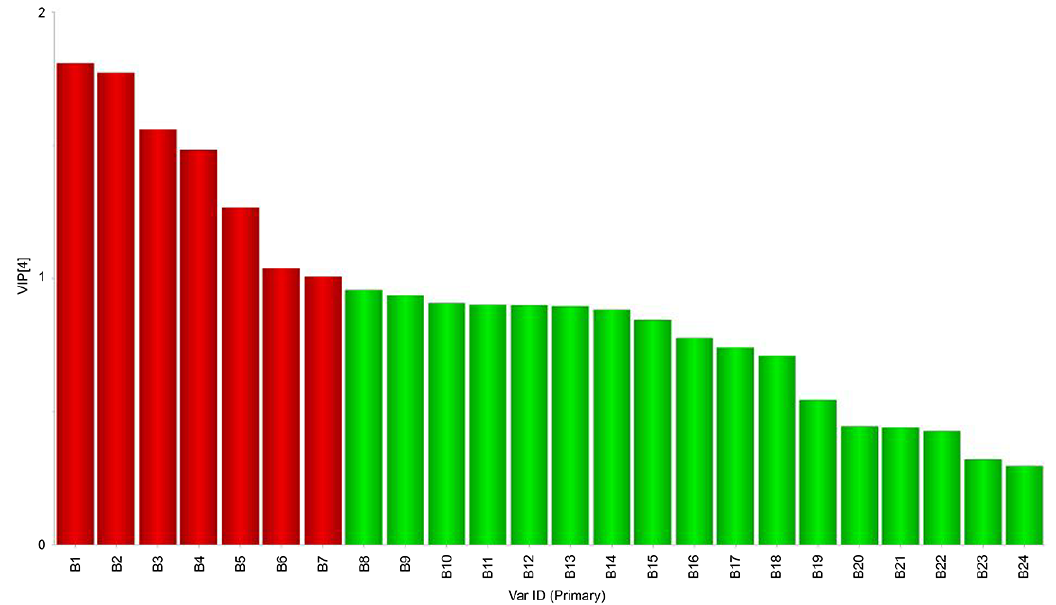
Figure 9. Analysis of the microbiota and biogenic amines using a VIP plot of bacteria and